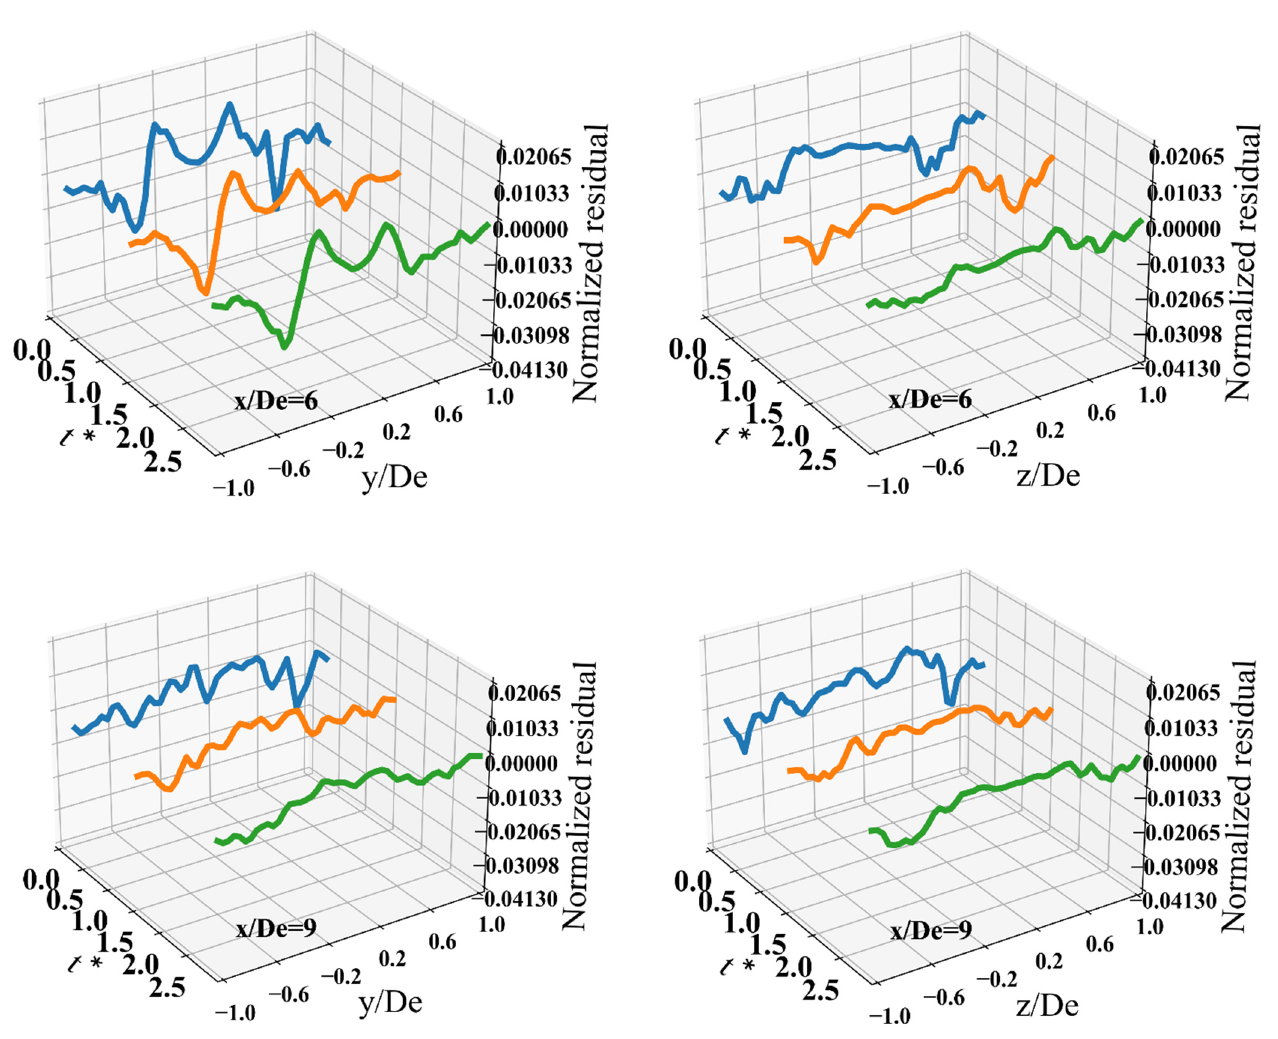
ρ j u 3 j (cid:3096) (cid:3285) (cid:3048) (cid:3285)(cid:3119) ) along streamwise locations D e (cid:3005) (cid:3280)